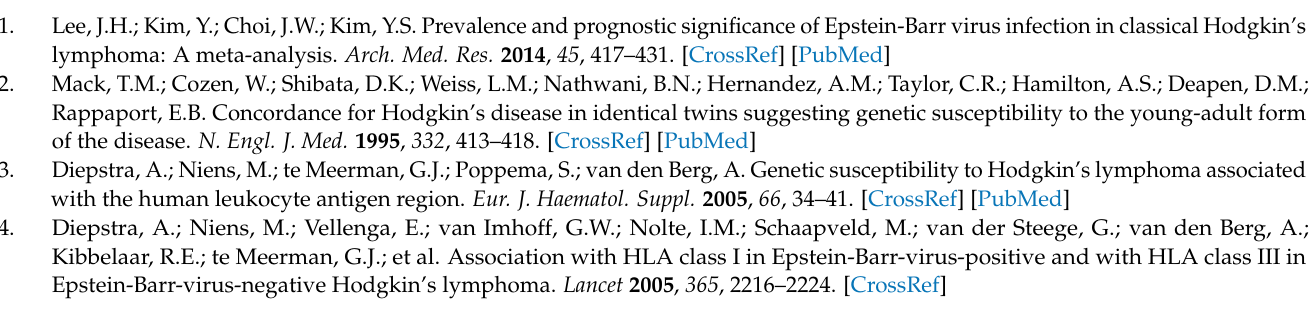
cell lines. Figure S3. Western blot of ERAP1 and ERAP2 protein. Figure S4. Sensitivity analyses for testing the association between genotypes of 12 missense SNPs of the ERAP1 and ERAP2 gene loci and HLA-phenotype in HL patients. Figure S5. Sensitivity analyses for testing the association between 12 missense SNPs genotypes of the ERAP1 and ERAP2 gene loci and HLA-genotype HL. Figure S6. Schematic representation of the HL cases included in this study. Table S1. Minor allele frequencies of selected SNPs in the ERAP1 and ERAP2 genes in LCL controls and HL patients. Table S2. Cell lines used in this study. Table S3. ERAP1 haplotypes in CEU controls and HL patients. Table S4. ERAP SNP—HLA allele interactions with (nearly) significant associations. Table S5. ERAP1 haplotype—HLA type interactions with (nearly) significant associations. Table S6. Sequence of the primers used for